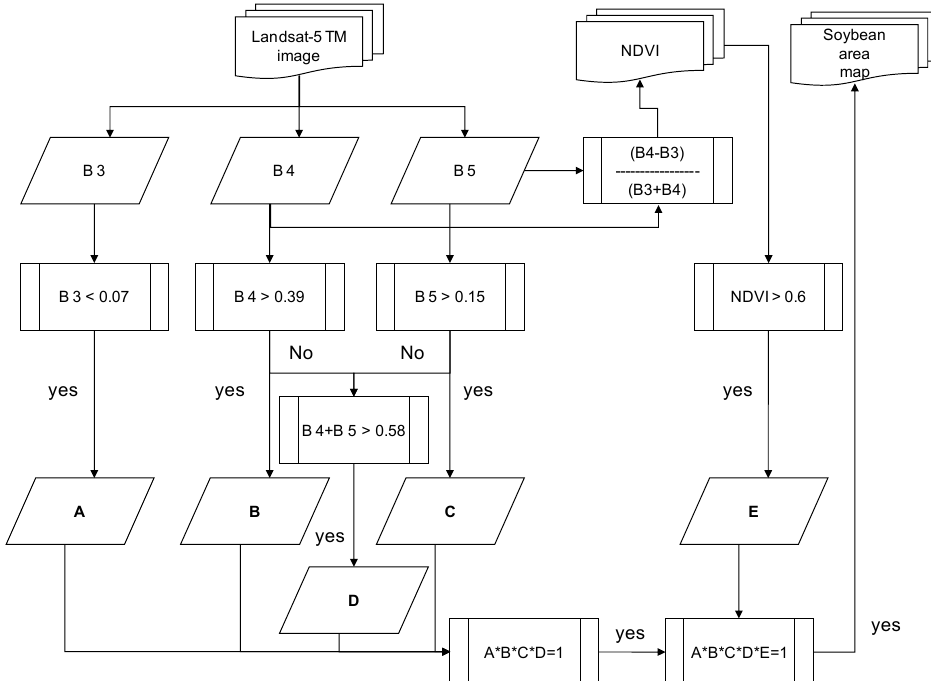
Figure 2. Flowchart of the Reflectance-based Crop Detection Algorithm